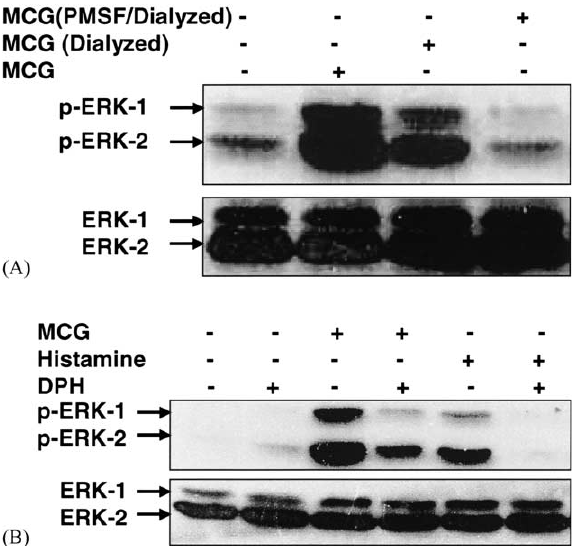
FIG. 5. The involvement of proteases and histamine in MCG- induced activation of ERK1/2. Confluent HUVECs (5 (cid:5) / 10 6 ) were incubated with MCG, dialyzed MCG, PMSF-pretreated and dialyzed MCG (2.5 (cid:5) / 10 6 mast cell equivalents) (A), or with histamine (25 m mol/l) in the absence and presence of diphenhydramine (25 m mol/l) (B) for 30 min. After the treatments, cell lysates were prepared and subjected to SDS-polyacrylamide gel electrophoresis followed by immu- noblotting with phospho-specific ERK1/2 monoclonal anti- body. Protein loads were monitored by western blot using ERK1/2 antibodies. Similar results were obtained in three